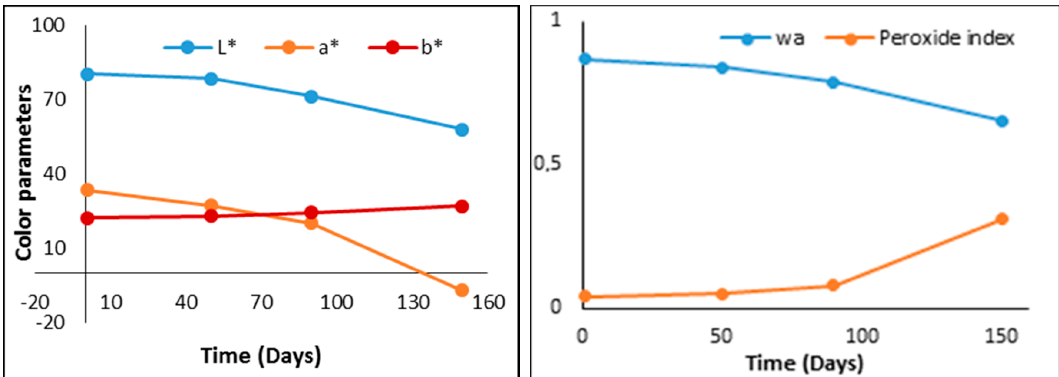
Figure 4. Evolution in time of analyzed parameters of sliced cheese (peroxide index is expressed in meq O2/kg of samples).